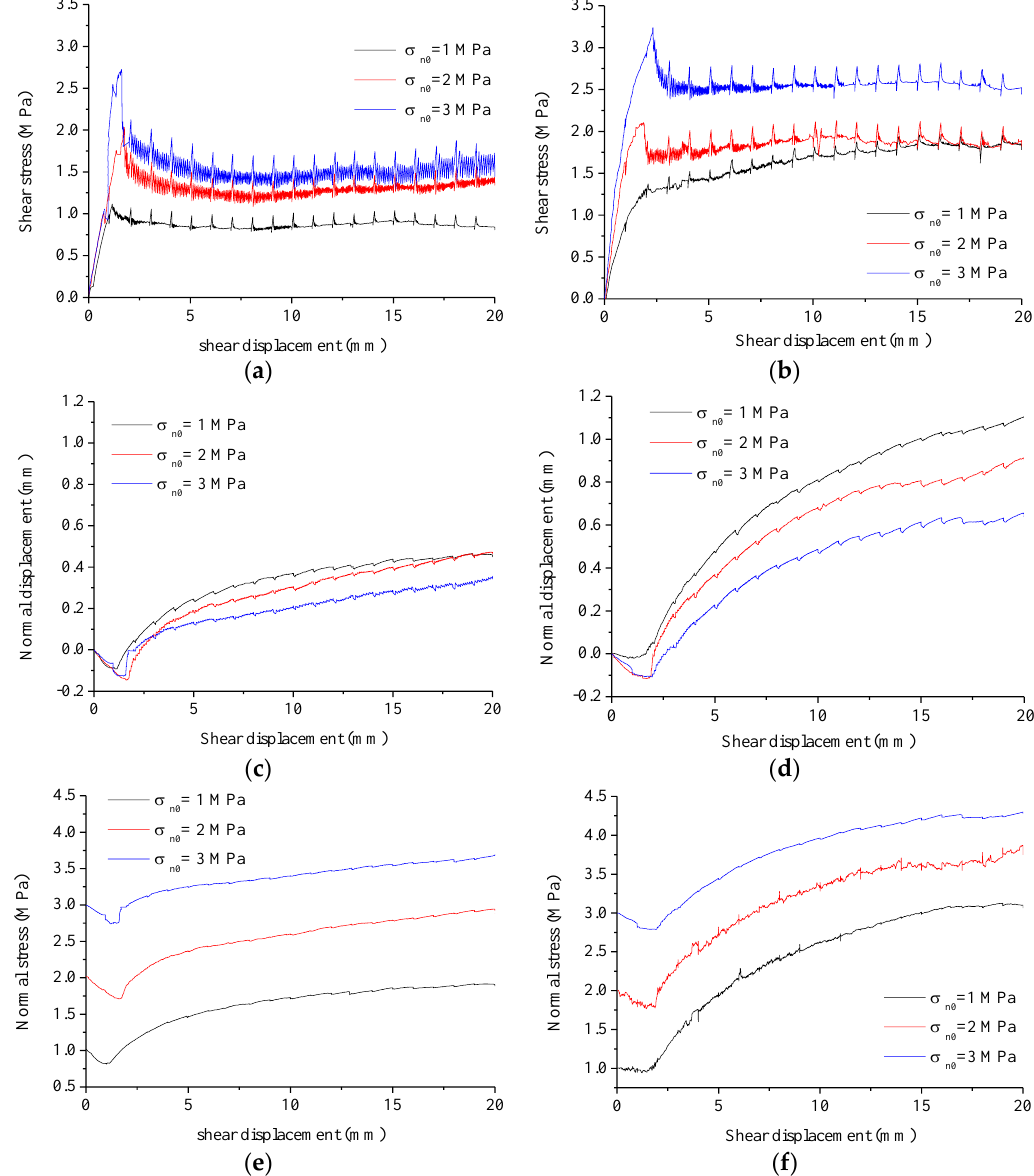
Figure 3. Shear behavior of the rock fracture replicas with different initial normal stresses. ( a , b ) Shear stress vs. shear displacement for the replicas G1 and G3; ( c , d ) Normal displacement vs. shear displacement for the replicas G1 and G3; and ( e , f ) Normal stress vs. shear displacement for the replicas G1 and G3.